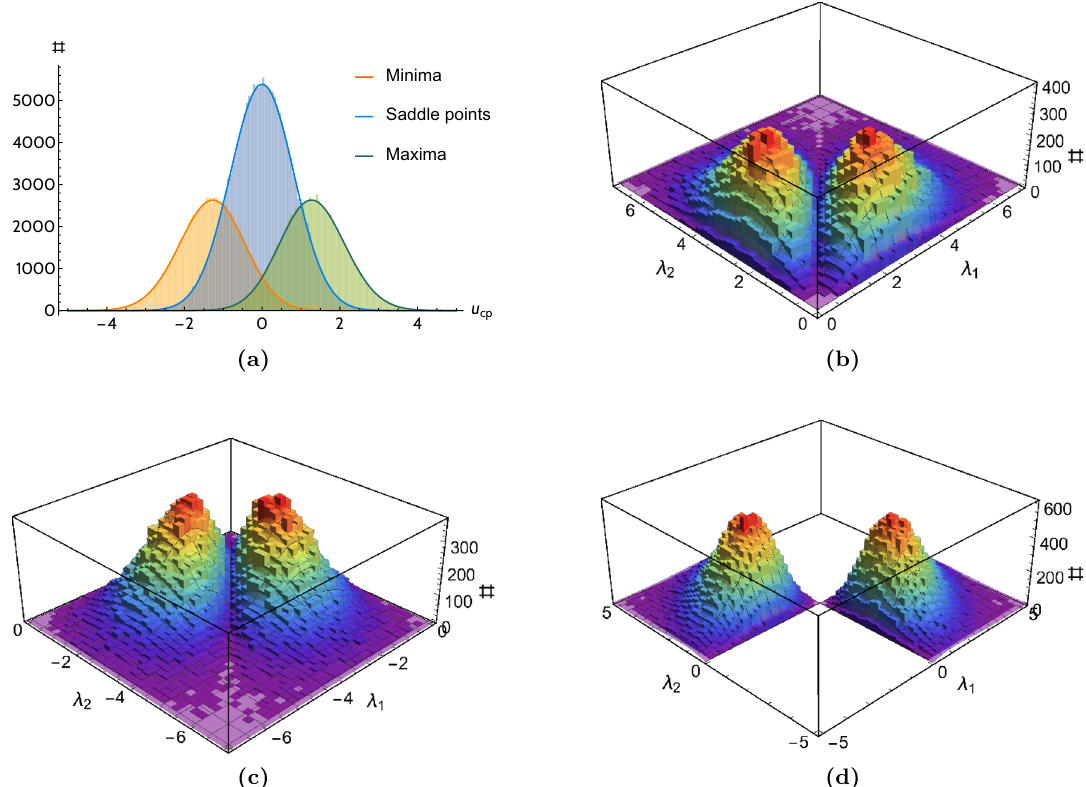
Figure 13. Histograms of (a) heights and (b-d) eigenvalues for critical points, normalized to expected values, from a 10 5 (cid:3) 2 GRF. Distributions (B.5) and (B.6) are plotted along with their respective histograms, normalized with respect to